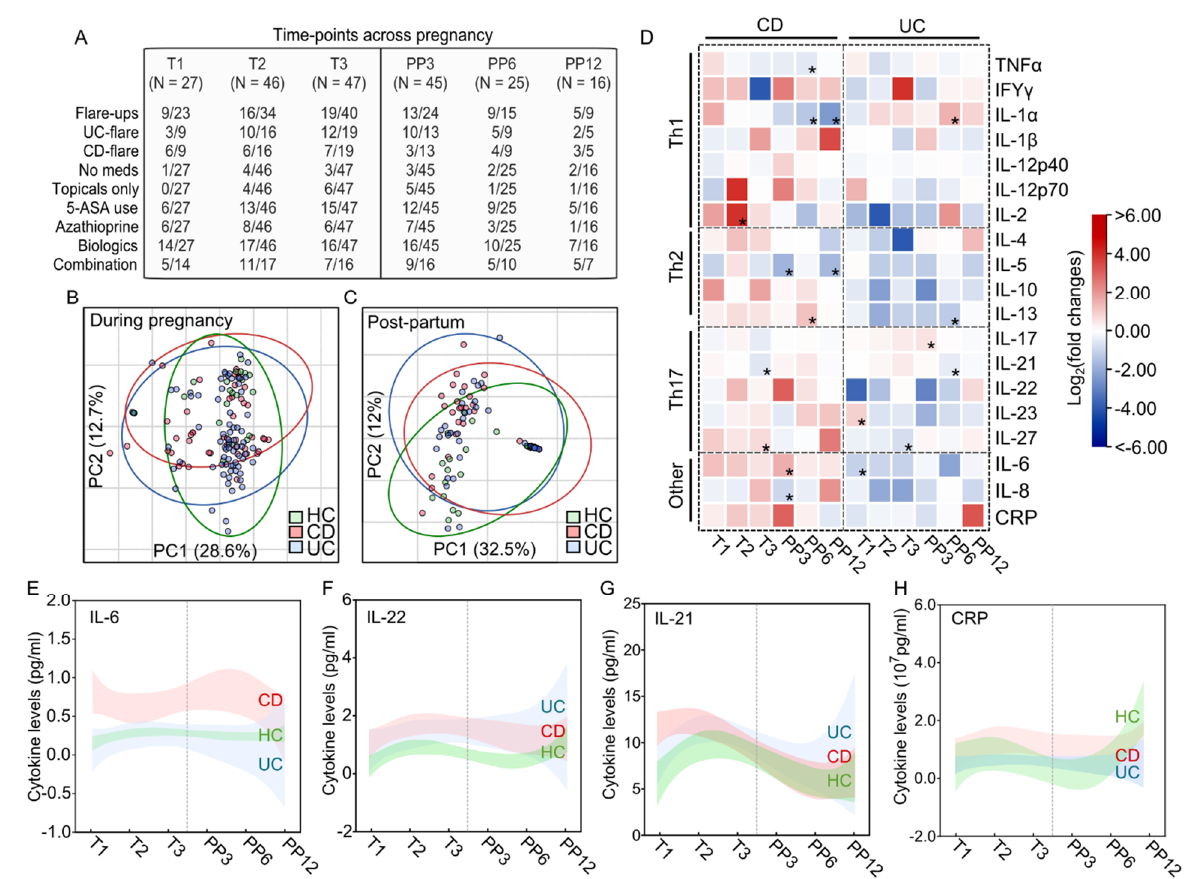
Figure 2. IBD status and subtype influence maternal serum cytokines throughout pregnancy. ( A ) IBD characteristics of the entire cohort of women with IBD by disease flare-ups and medications used (N = 16–47 per group). Principal coordinate analyses (PCA) of cytokine changes at ( B ) T2 and ( C ) PP3 by IBD disease subtype (N = 7–32 per group). ( D ) Heatmap demonstrating the log 2 (fold changes) of serum cytokines across pregnancy (N = 16–47 per group). Logarithmic lines of best fit illustrating the cytokine variations across pregnancy for ( E ) IL-6, ( F ) IL-22, ( G ) IL-21, and ( H ) CRP. Shaded areas denote 95% confidence intervals. HC denotes healthy control. T1–3 denotes trimesters 1, 2, and 3, whereas PP3–12 signifies post-partum months 3, 6, and 12. * signifies p < 0.05 using unpaired Student’s t -test.